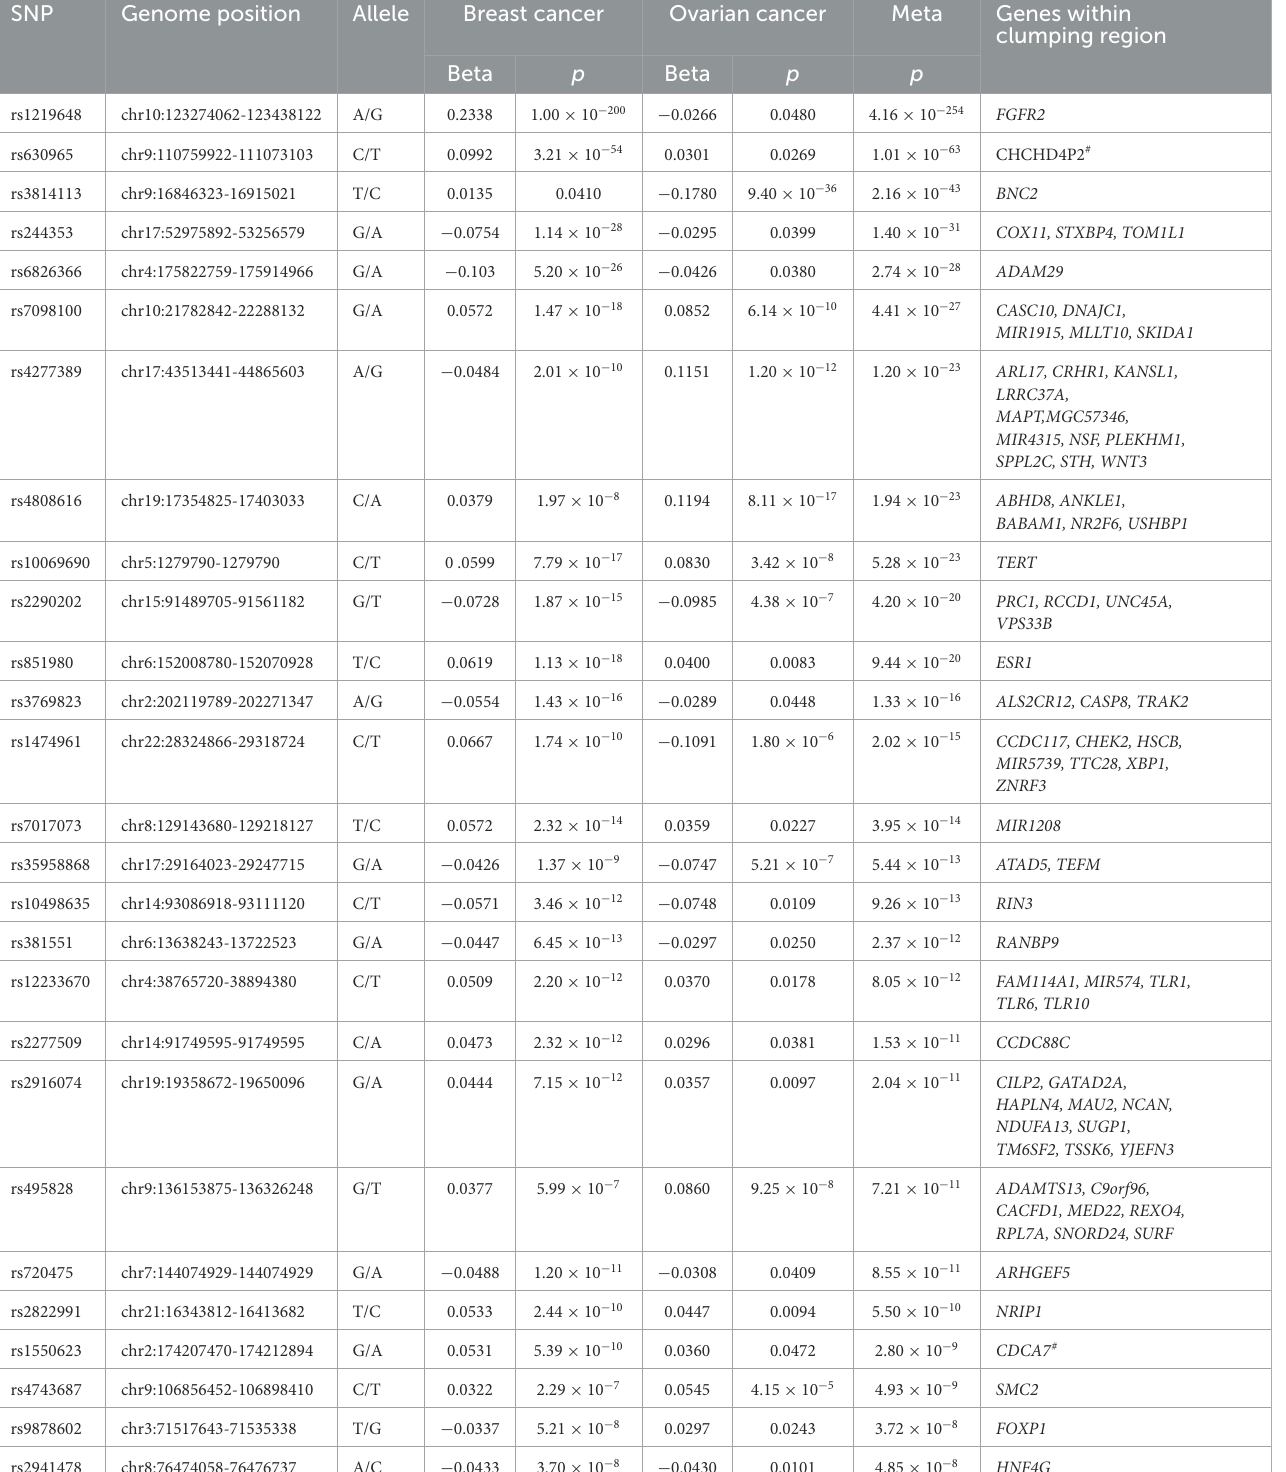
TABLE 2 Cross-trait meta-analysis result between breast and ovarian cancers ( p meta < 5 × 10 − 8 ; single-trait p < 0.05).